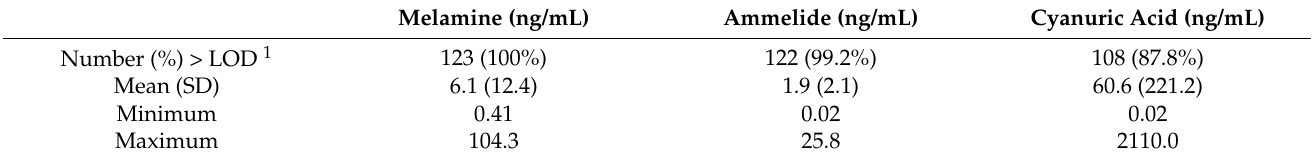
Table 1. Distribution of melamine and related compounds in spot urine samples of 123 children aged 4–6 years in the PATHWAYS GAPPS